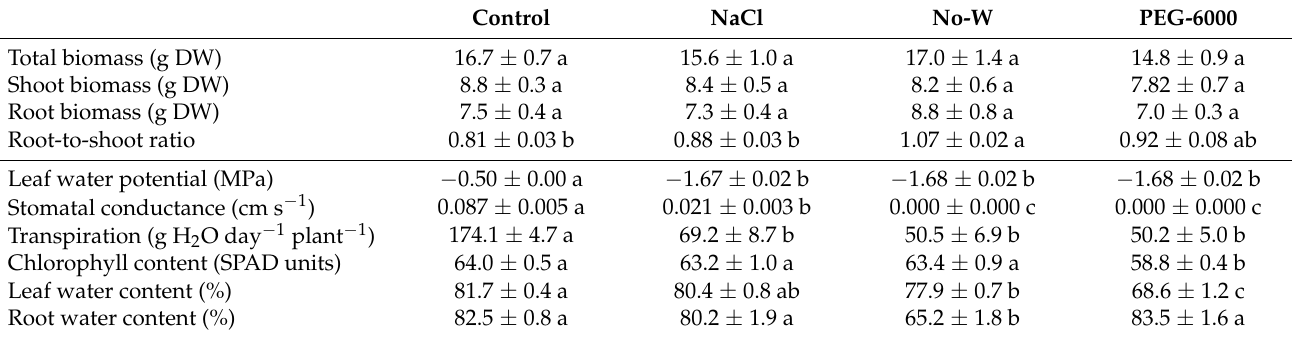
Table 1. Physiological responses under different iso-osmotical conditions.